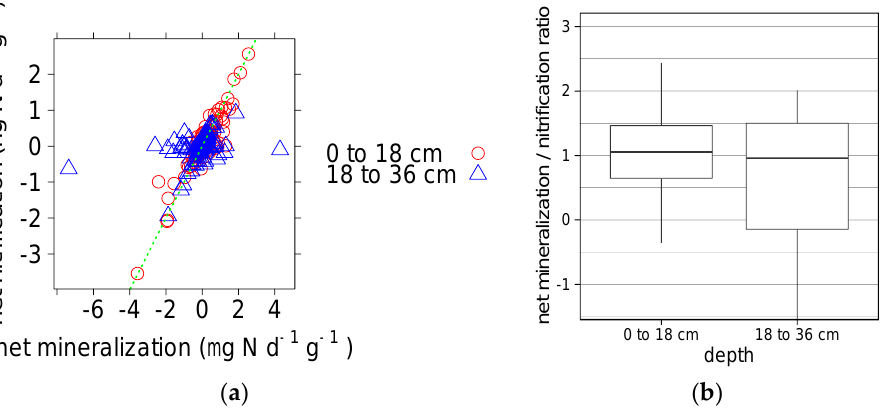
Figure 8. Relationship between net nitrogen mineralization and net nitrification (μg nitrogen (N) d −1 g −1 dry soil) for shallow and deep halves of soil cores at seven bioswales ( n = 209) ( a ) Dotted line denotes 1:1 ratio; ( b ) Net mineralization/nitrification ratio.